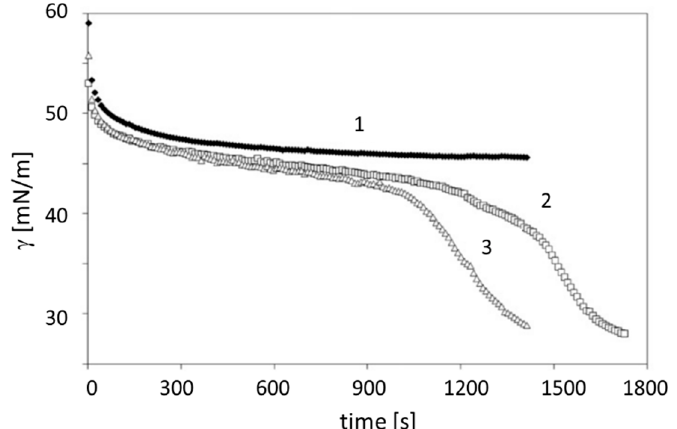
Figure 1. The dependence of the dynamic surface tension of the umbilical blood taken during the first day of life: (1) premature newborn from the reference group; (2,3) two newborns with immature lungs suffering from congenital pneumonia; data taken with permission from [28].